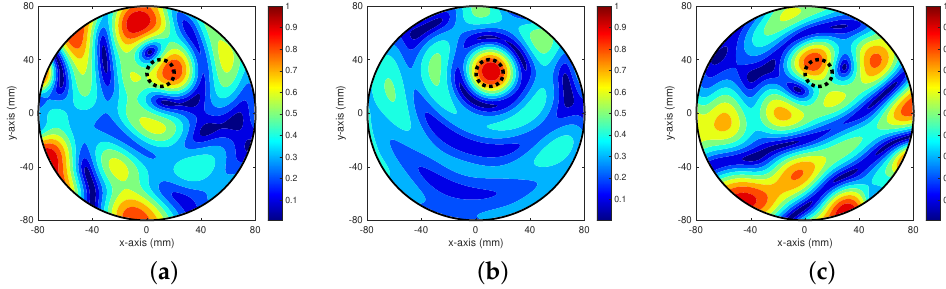
Figure 8. (Example 6) Imaging results via the direct sampling method with difference location of sources a 5 , a 10 , and a 15 . Black-colored dashed line describes the boundaries of objectives. ( a ) Imaging with source a 5 , ( b ) Imaging with source a 10 , ( c ) Imaging with source a 15